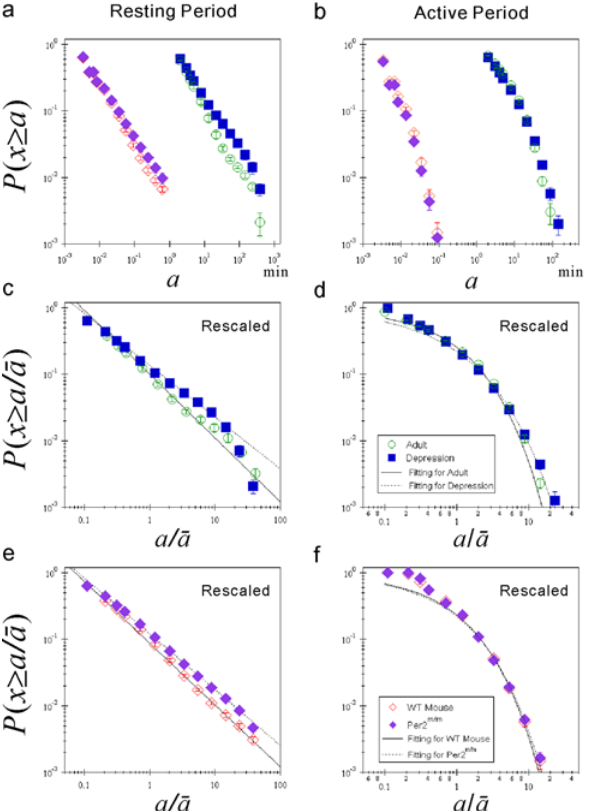
Figure 5. Breakdown of the universal distribution laws. ( a ) Cumulative distributions P ( x $ a ) of resting period durations for healthy human adults (open circles) and depression patients (closed squares) [3], wild-type (WT) mice (open diamonds) and the Period2 mutant ( Per 2 m / m ) mice (filled diamonds). The error bars indicate the standard error of the mean. ( b ) The same as ( a ), but for active period durations. ( c ) Group averaged rescaled cumulative distributions for healthy human adults and depression patients, reproduced from our recent study [3]. ( d ) The same as ( c ), but for active period durations. ( e ) Group averaged rescaled cumulative distributions for WT and Per 2 m / m mice. ( f ) The same as ( e ), but for active period durations. Note that the plots in ( d ) and ( e ) are shifted along the vertical axis to take the same value at a = a ~ 0 : 1 for the purpose of illustration. The lines are eye-guides with the group mean parameter values in Table